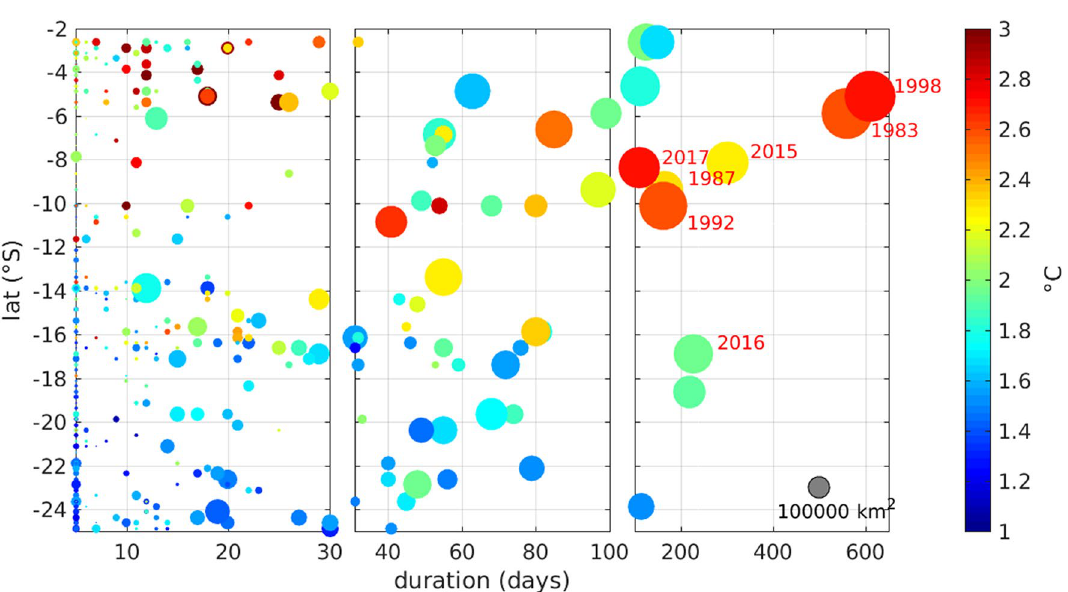
Figure 2. Scatter plot of MHWs duration organized by latitude. The dot size is function of the maximum surface occupied by the MHW on one day (the grey dot indicates a 10 to the surface temperature anomaly averaged over the duration of the event. Years are indicated for all category 4 MHWs. The figure was created using Matlab R2020b (https:// matlab. mathw orks.